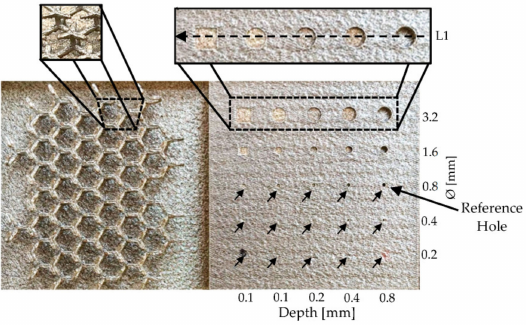
Figure 1. LPBF-produced part. Left side with a 3D hexagonal lattice and right side with a pattern with different diameters and depth holes (squared holes in the left-most column).